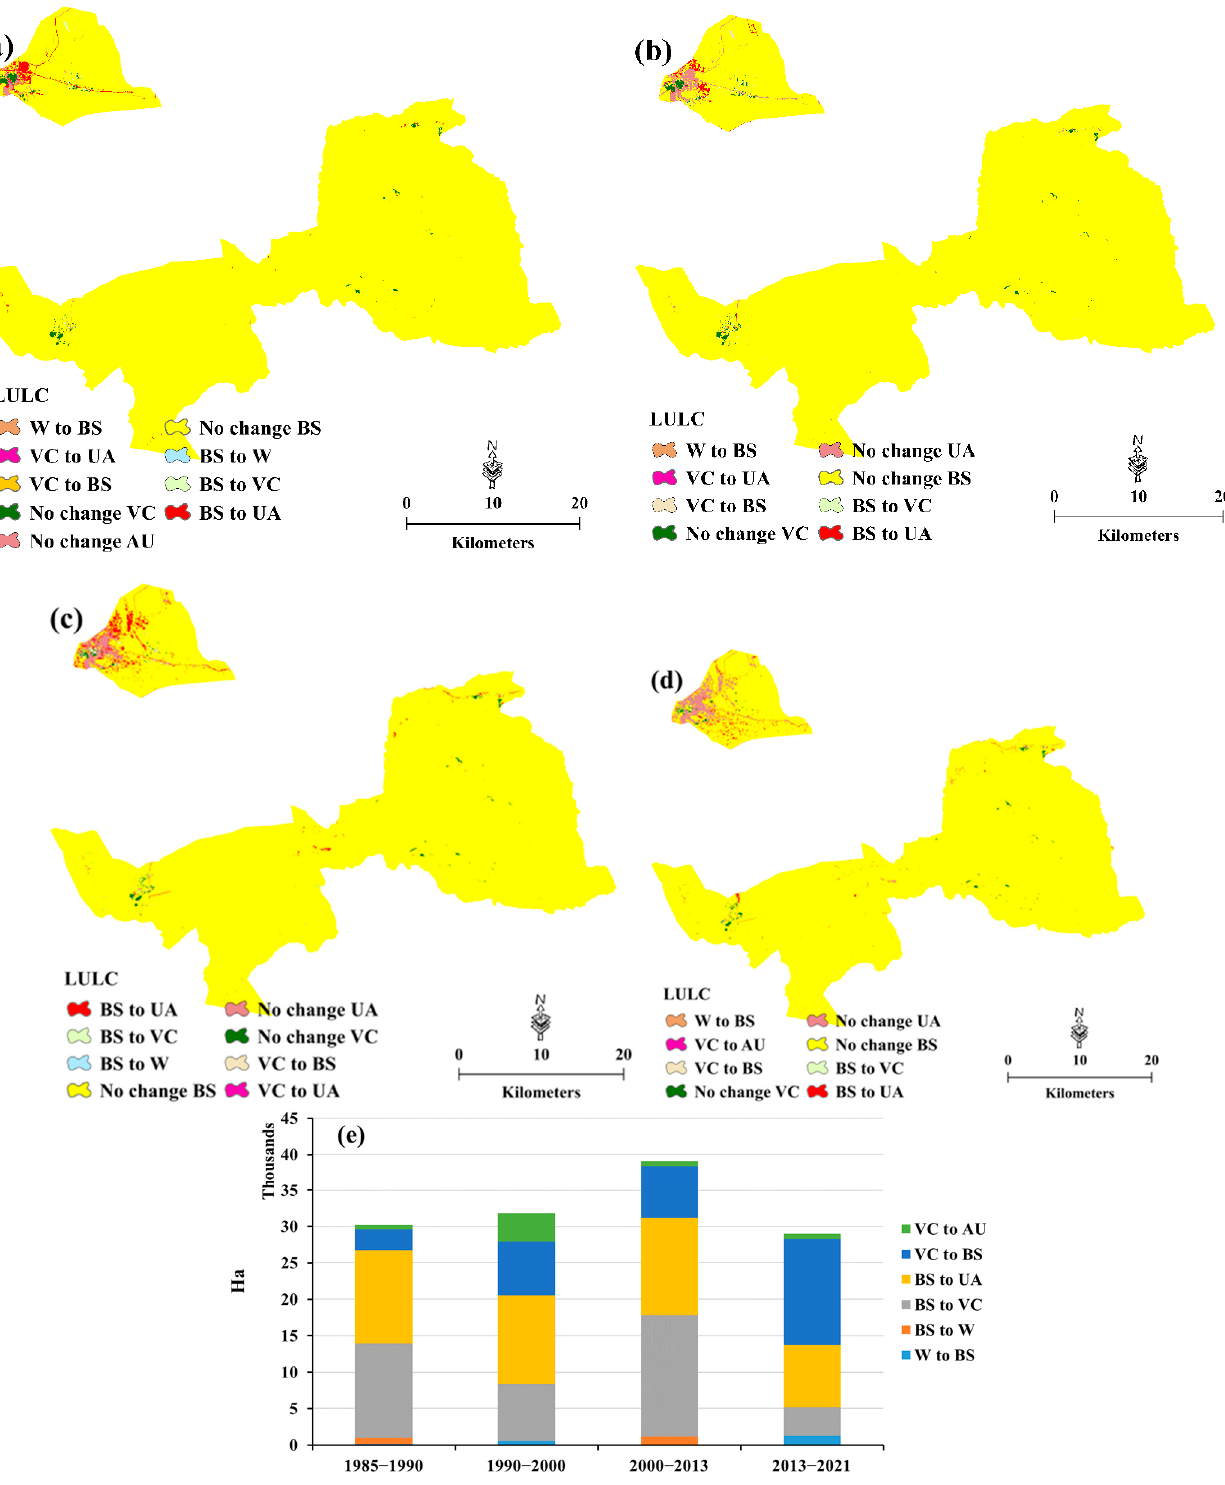
Figure 8. LULC in Al-Buraymi ( a ) 1985–1990, ( b ) 1990–2000, ( c ) 2000–2013, ( d ) 2013–2021, and ( e ) the overall LULC changes for 1985–2021 (BS = Bare Soil; VC = Vegetation Cover Soil; UA = Urban Area; W = Water).